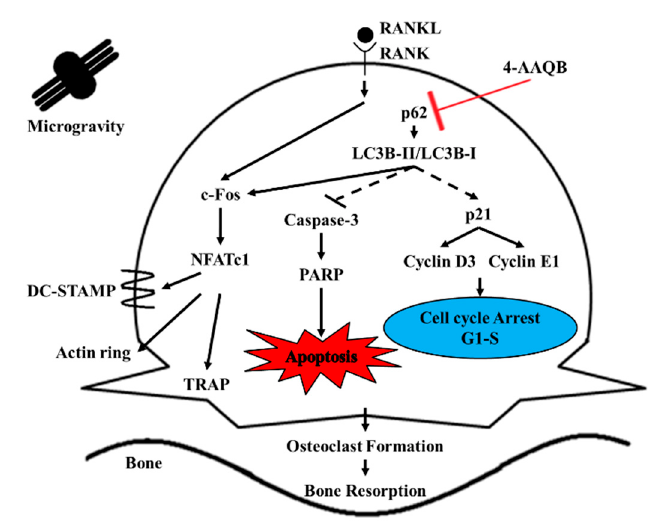
Figure 7. Proposed mechanisms of 4-AAQB in osteoclastogenesis.